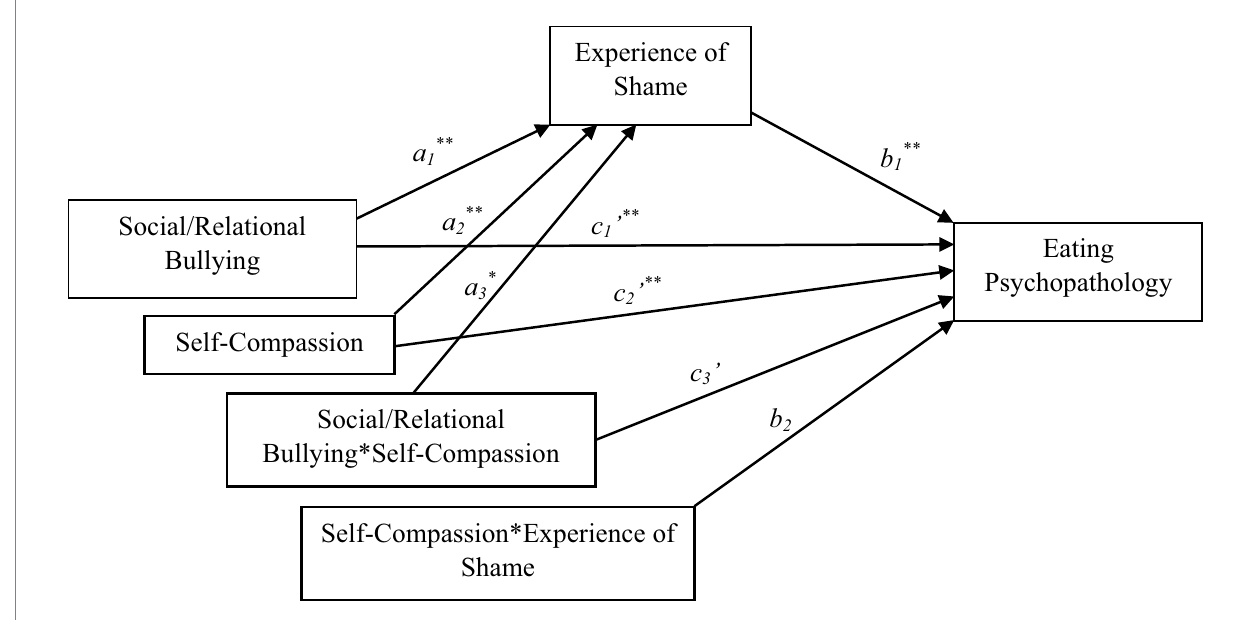
FIGURE 2 Statistical model of conditional mediation. See Supplementary Table S1 in Supplementary File for model coefficients. p < 0.005, ** p <